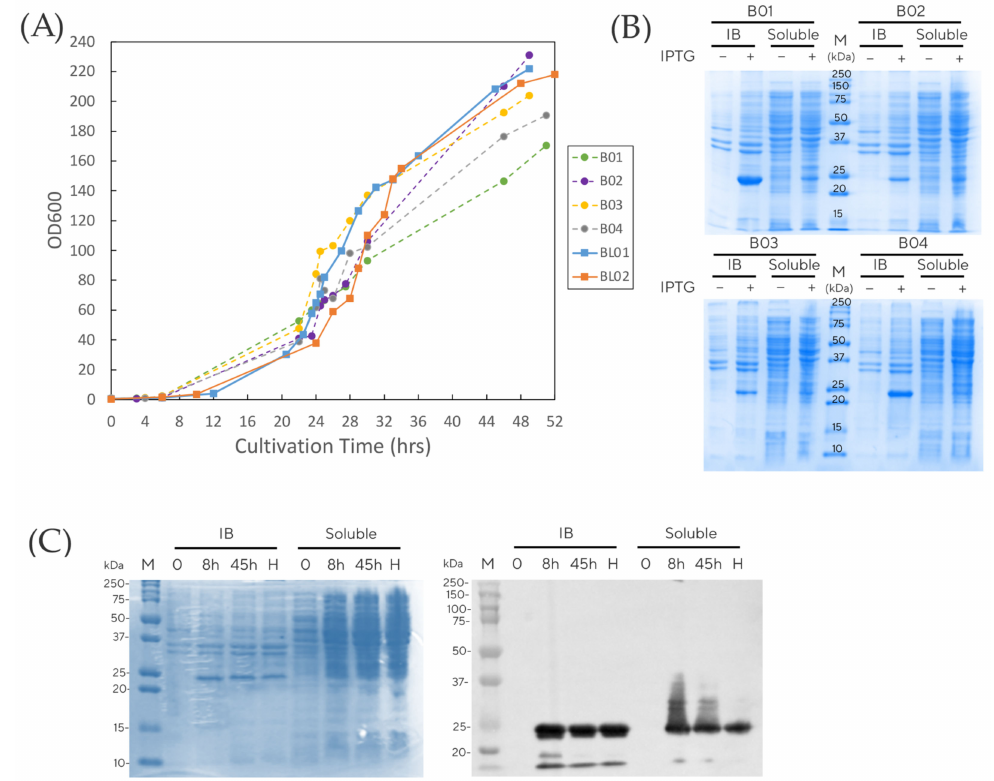
Figure 2. Fermentation results: ( A ) growth curve of E. coli producing PCV2d at bench scale (B01–B04) and pilot scale (BL01 and BL02), ( B ) SDS-PAGE analysis of PCV2d produced at bench scale, and ( C ) SDS-PAGE and Western blot analysis of PCV2d produced at pilot scale. IB = inclusion body, Soluble = supernatant, M = marker and H = harvest